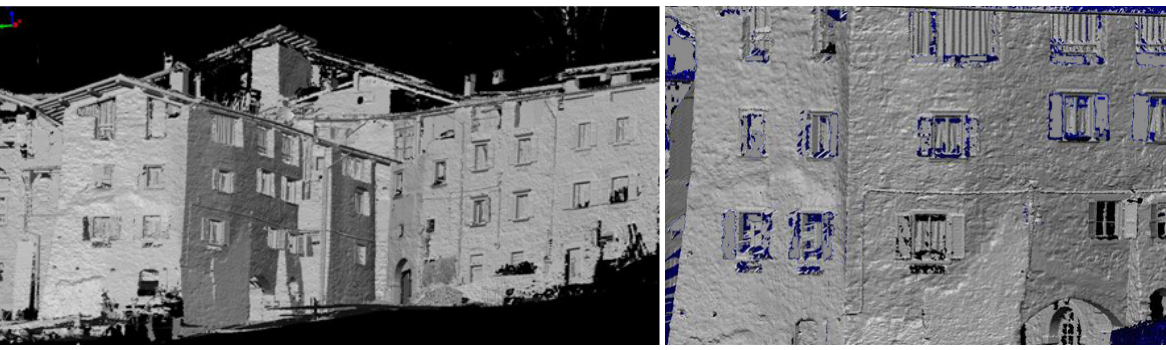
Figure 11: Some 3D results for the Calvola village. For such complex structure, the hole filling procedure is the most time consuming part of the 3D modeling pipeline.